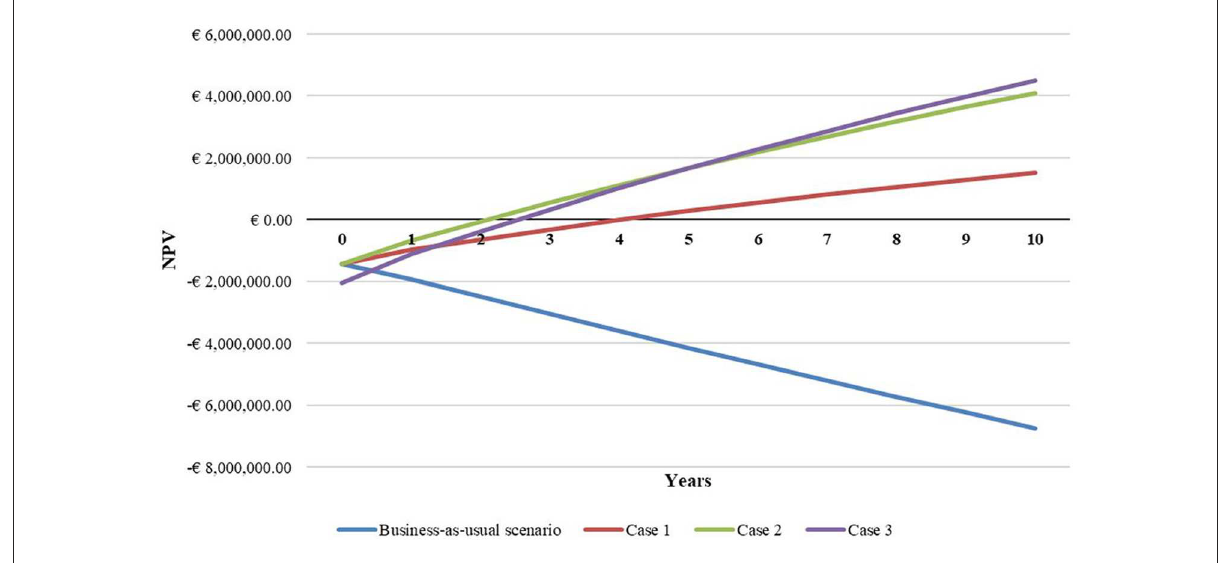
FIGURE1 NPV values in the 10 years of investment for the four